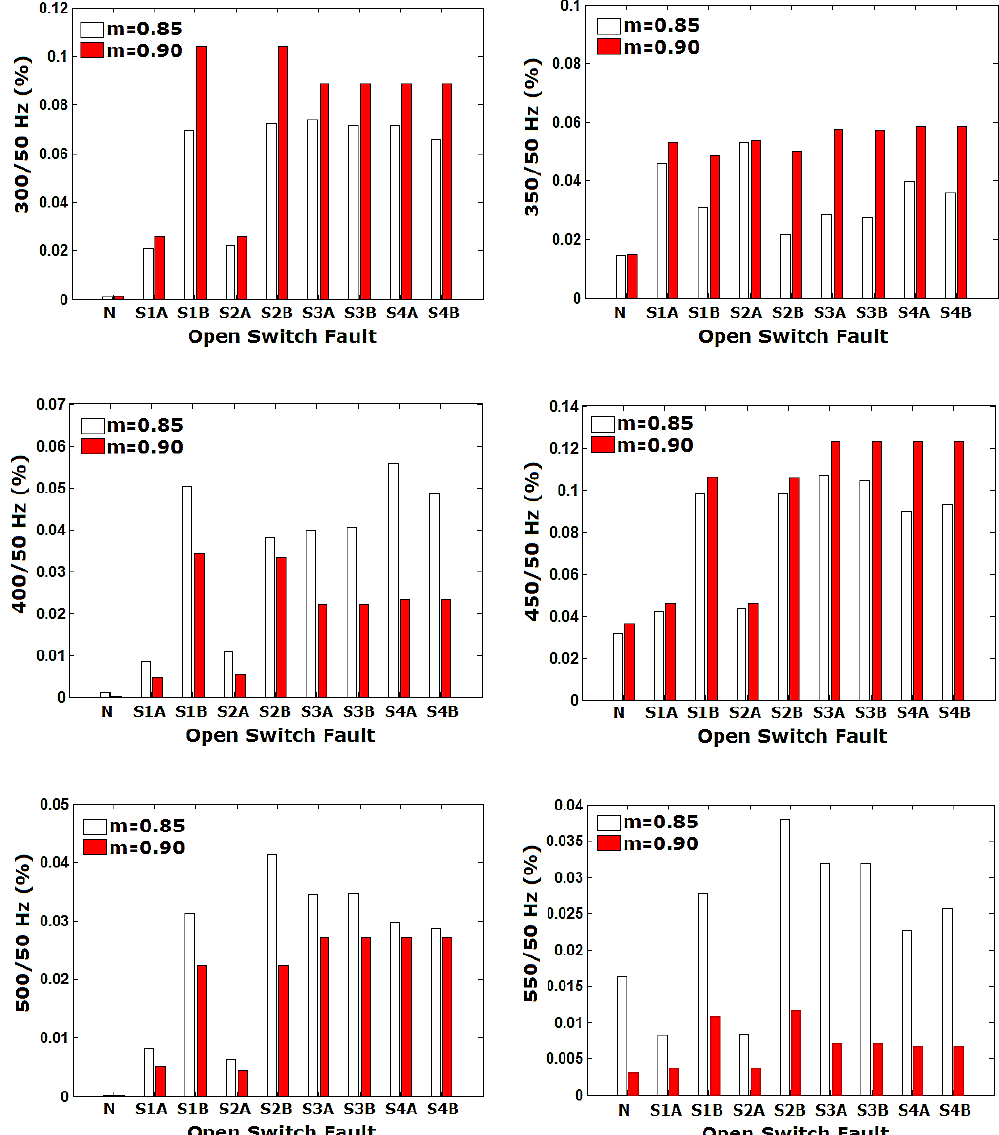
Figure 8. Features of the output voltage waveform acquired from FFT technique at distinct open switch fault cases from 2nd harmonic ratios to 11th harmonic ratios.